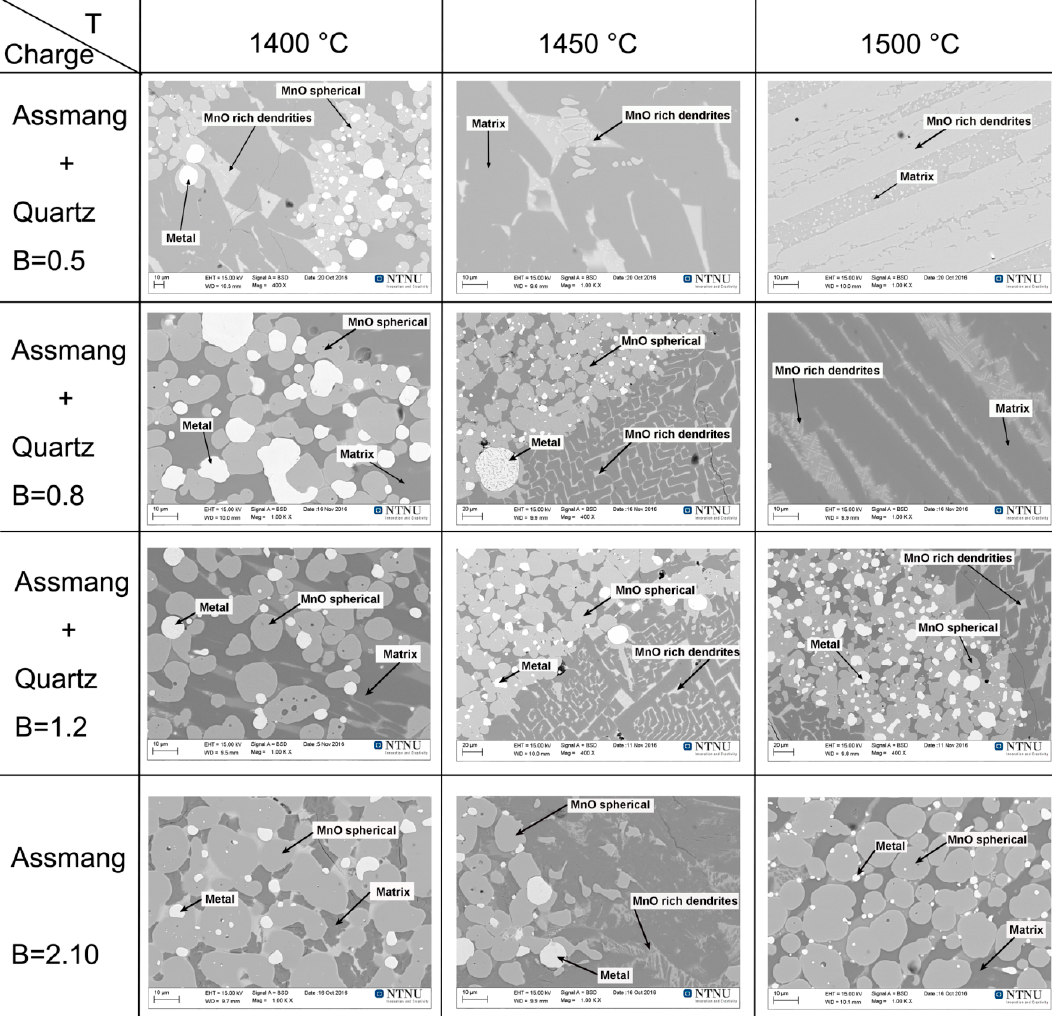
Figure 6. Electron backscatter images of Assmang charges with different basicities at different temperatures.